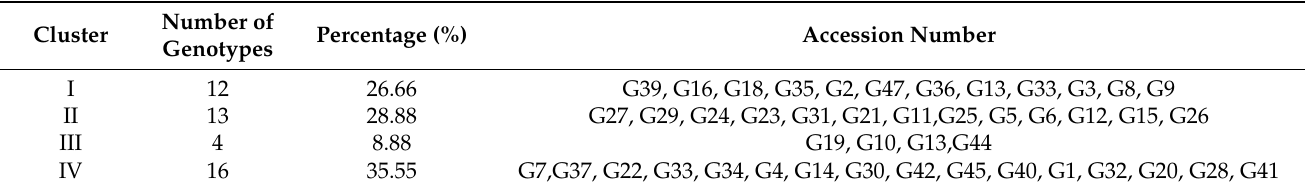
Table 6. Cluster analysis of forty-five maize genotypes.